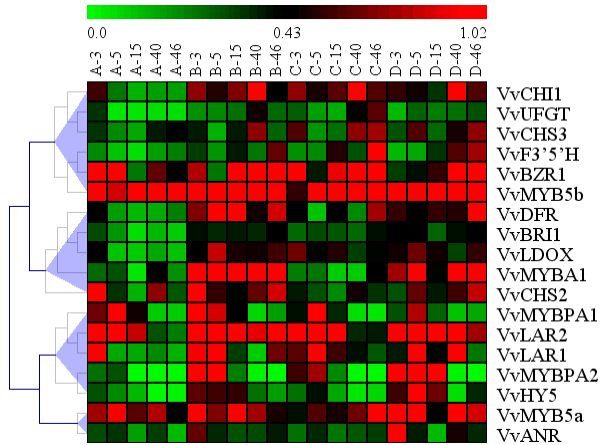
Figure 8. Hierarchical clustering of the transcript profiles of all genes. The relative expression levels of the genes after the four treatments compared to the reference gene, used in the original rank-based algorithm, were used for the hierarchical cluster analysis with Genesis. Red colors represent relatively higher transcript abundances, and green colors represent relatively lower transcript abundances. Sampling times and treatments are indicated at the top; the numbers A, B, C and D represent treatments D, L, EBR + D, EBR + L, respectively, and the numbers 3, 5, 15, 40 and 46 are days after treatment.